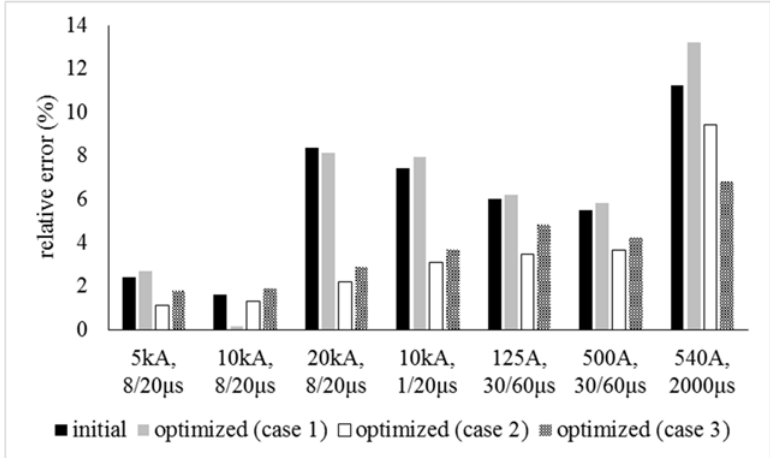
Figure 9. Results for the Fernandez–Diaz model.